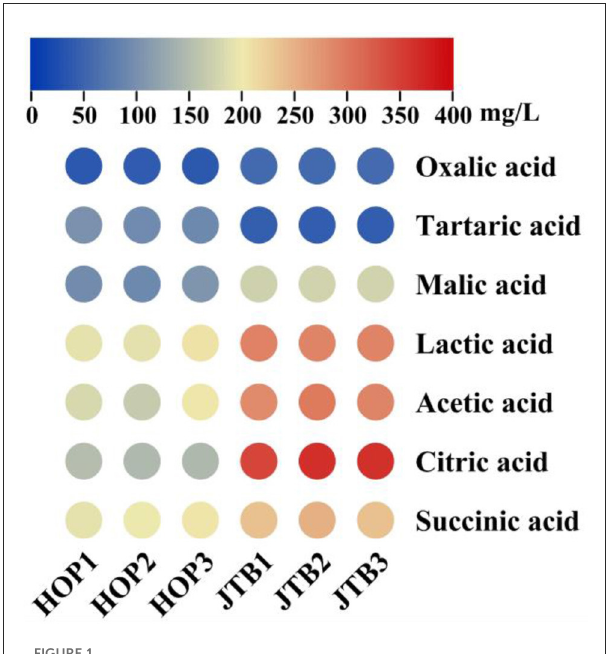
FIGURE1 Heat map of seven organic acids.